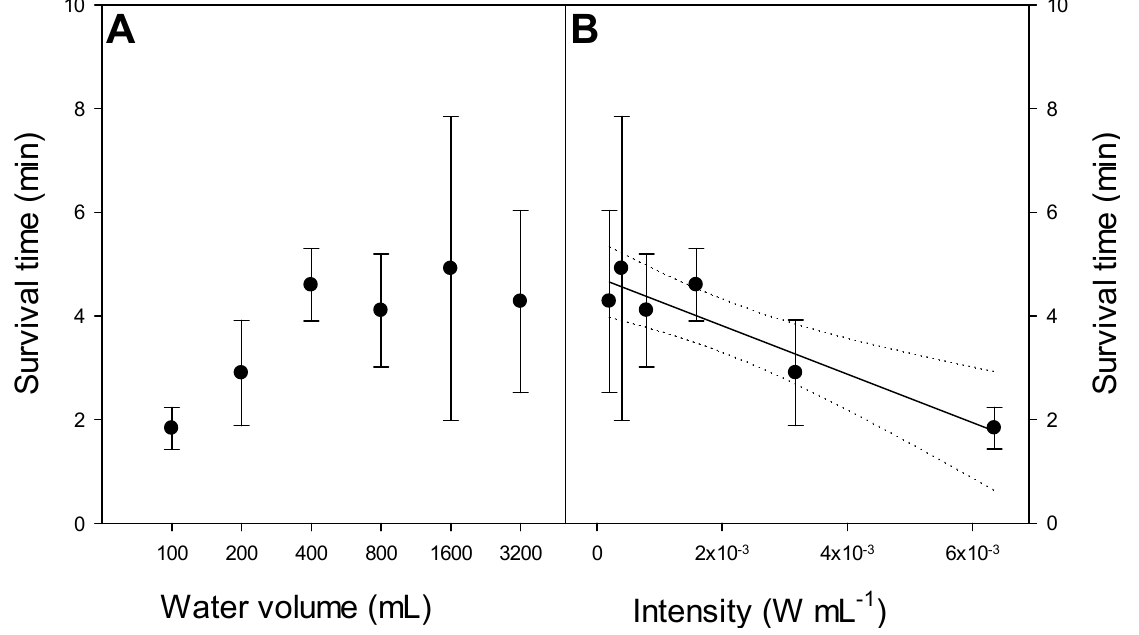
Figure 2. Left panel A : Survival time (min) of D. magna exposed to 44 kHz ultrasound in volumes ranging from 100 mL to 3200 mL. Error bars indicate one standard deviation ( n = 3); Right panel B : Relationship between mean survival time (ST) of Daphnia magna (body-size 1.94 ± 0.12 mm) and ultrasound intensity (IUS, in W·mL − 1 ); ST = 4.747 − 467.8 × IUS ( r 2 = 0.880). Solid line represents linear regression, the dotted lines indicate the 95% confidence and the error bars indicate one standard deviation ( n =